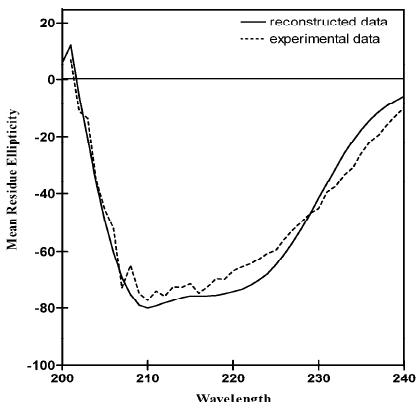
Figure 5. Far-UV circular dichroism (CD) spectrum of LvFSH represented as mean residue ellipticities (degree cm 2 dmol − 1 residue − 1 × 10 3 ). The experimental data (discontinuous line) and the reconstructed spectrum (continuous line) as calculated by K2D algorithm [56].